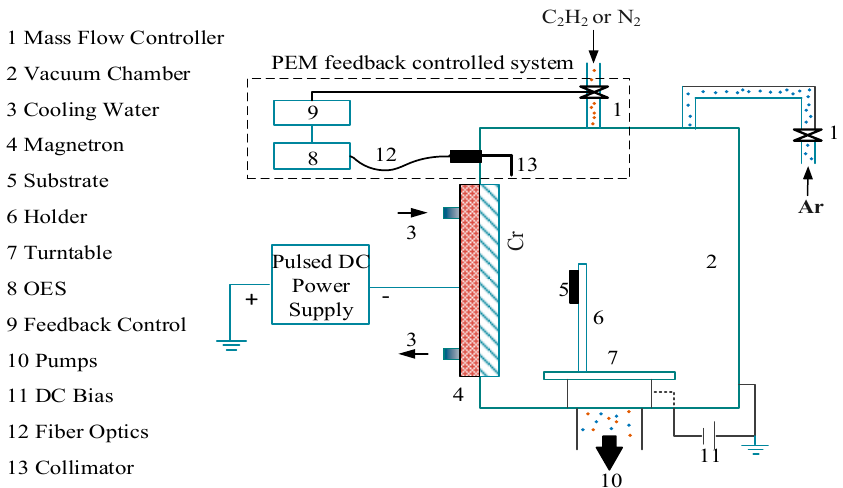
Figure 1. Schematics of deposition apparatus for Cr-containing hydrogenated amorphous diamond-like carbon (Cr-DLC) films.